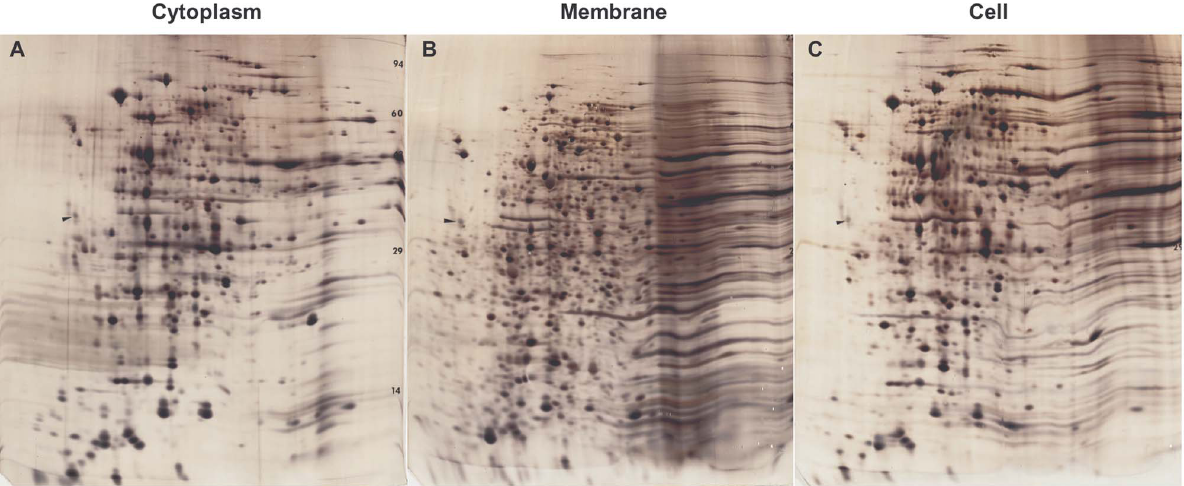
Figure 9. Gene expression. 2D gels of cytoplasm [A] , membranes [B] and whole cells [C] . Gels were aligned and scaled using 20 common spots on gel [ A ] as a reference. About 600 spots can be counted. The cytoplasm comprises about 25% of the mass. Compare to Table 2, which presents quantitative chemical analysis of unmodified proteins as well as the post-translationally modified glycoproteins and lipoproteins.